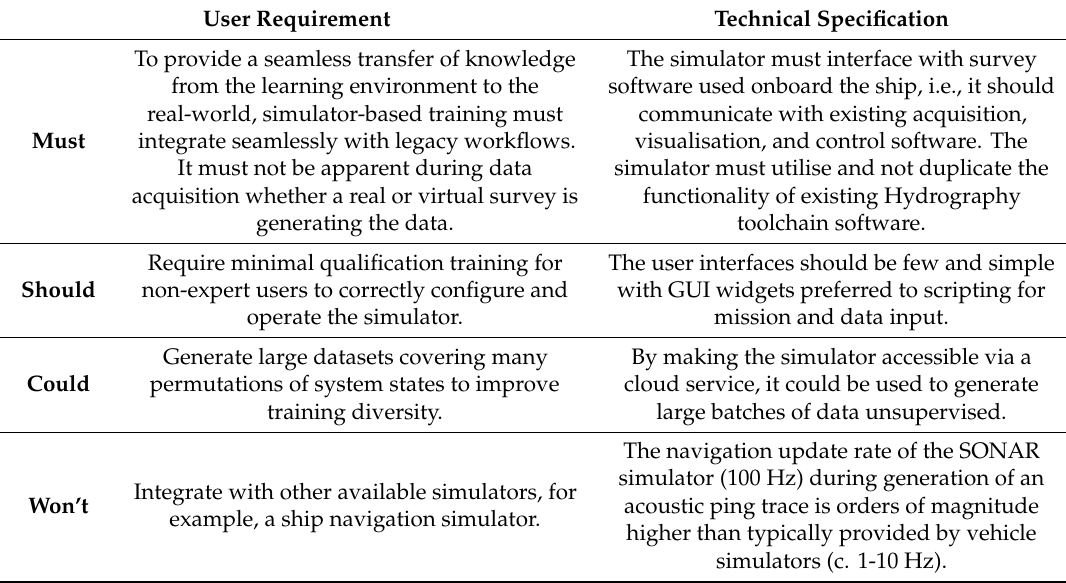
The key requirements identified and mapped to technical specifications during the pre-installation MoSCoW